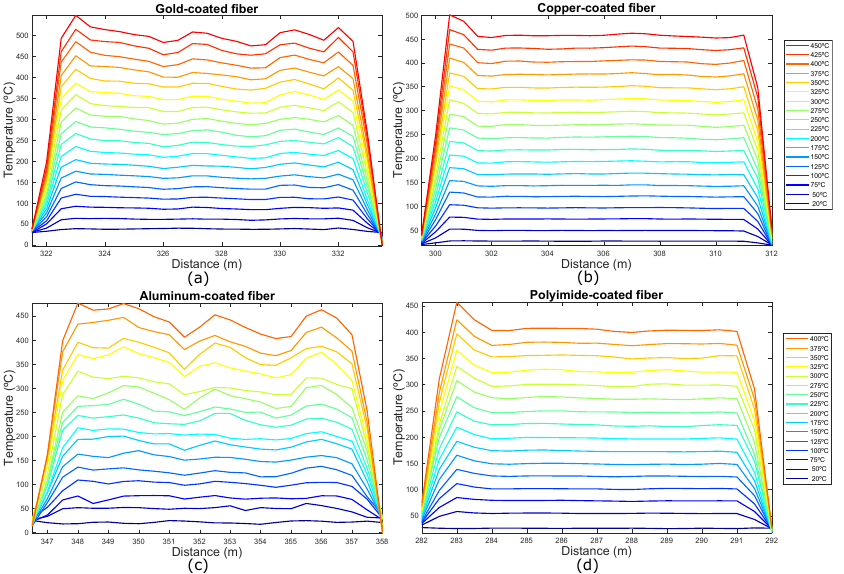
Figure 5. Temperature profile for ( a ) gold-coated; ( b ) copper-coated; ( c ) aluminum-coated and ( d ) polyimide/carbon-coated fibers in the hot-spot